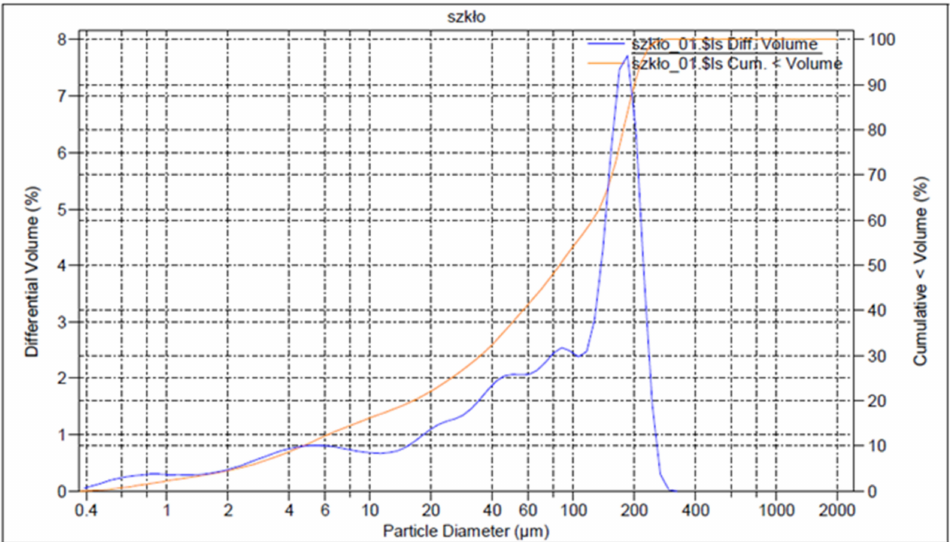
Figure 3. PV Glass powder grain distribution.